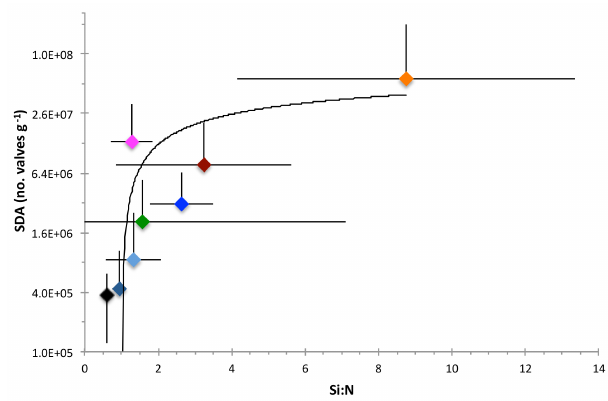
Figure 5. Relationship between average SDA ln (no. of valvesg − 1 ) and average Si:N estimated from the WOA13 database per up- welling system and considering only the true upwelling sites. Bars represent SD. Color scheme as in Fig.